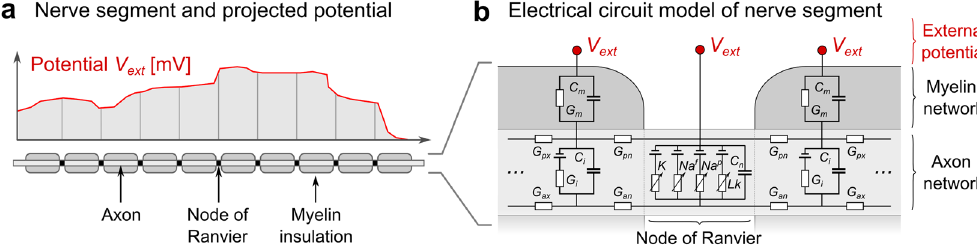
Figure 5. ( a) Schematic of the discretization of the potential V ext along the nerve segment with respect to the nodes of Ranvier. V ext is determined from integrating the induced electric field calculated in Step 2. Node spacing is assigned based on estimated fiber diameter. ( b) Electrical equivalent circuit for the MRG nerve model on each side of a node of Ranvier. Action potentials are created when the transmembrane potential change becomes greater than approximately 20